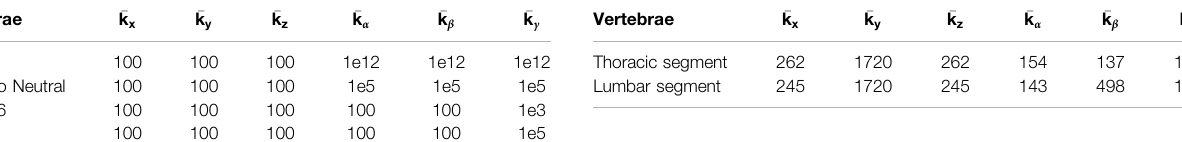
TABLE 1 | Error weights (in kN/m for translation, N/rad for rotation) for the fi tting function ( Eq. 1 ). Vertebrae